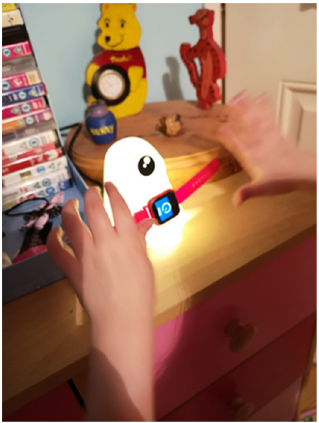
Figure 5. Alice ensures to place her watch on the charging port each night.